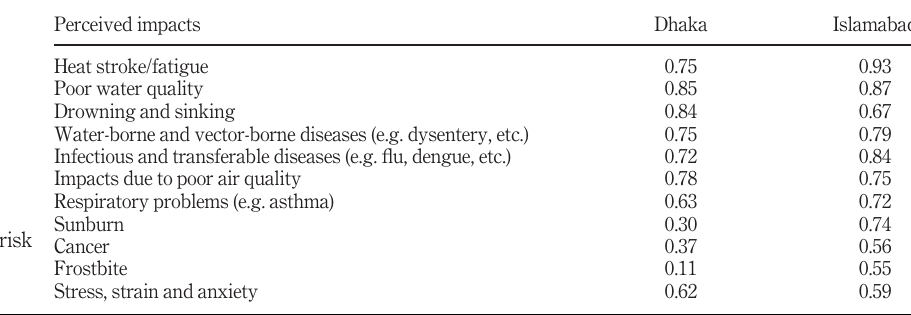
Table 3. Apparent health risk associated